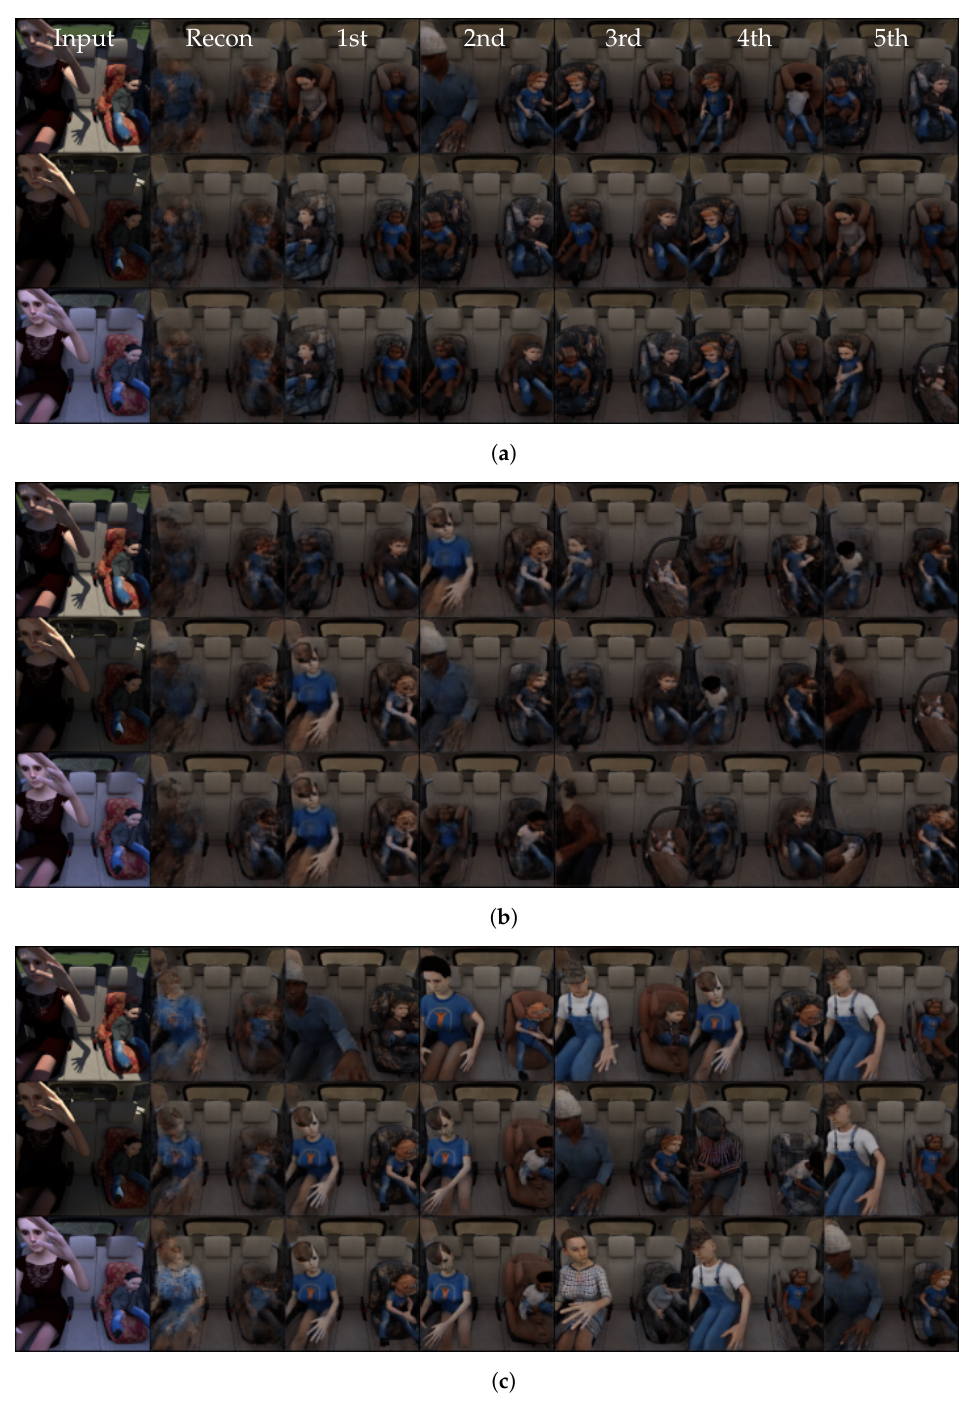
Figure 7. Comparison of the reconstruction of the 5 nearest neighbours (columns 3 to 7) for different encoder–decoder latent spaces ( a – c ). The reconstruction (second column) of the test sample (first column) is also reported. We used the I-PIRL and either used the triplet loss (TAE), the variational autoencoder (VAE) or just the vanilla reconstruction loss (AE). The triplet regularization is the most reliable and consistent one across all 5 neighbours. Notice the class changes across neighbours for the AE and VAE models. ( a ) I-AE. ( b ) I-VAE. ( c )